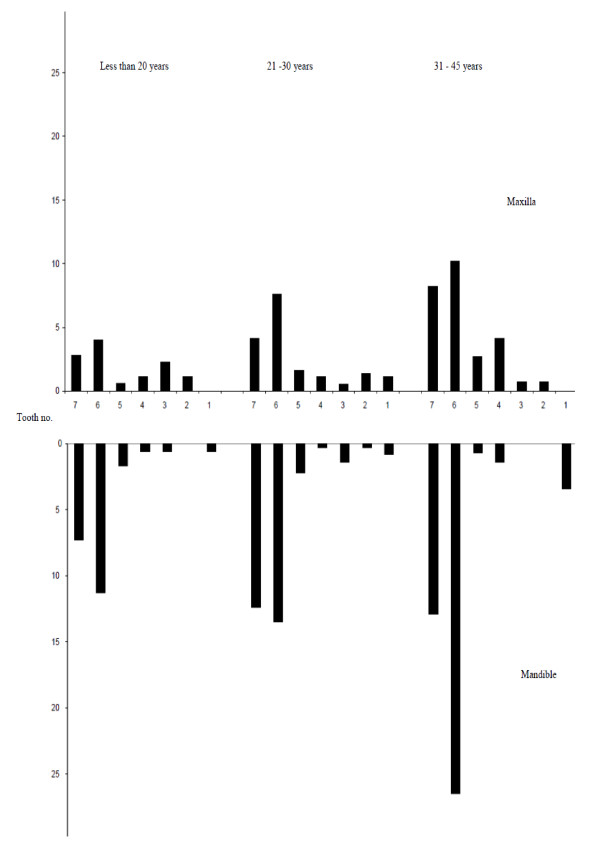
Percentage of tooth loss by tooth type and age group. Tooth number illustration: 1: Central Incisor, 2: Lateral Incisor, 3: Canine, 4: First premolar, 5: Second premolar, 6: First Molar, 7: Second molar.